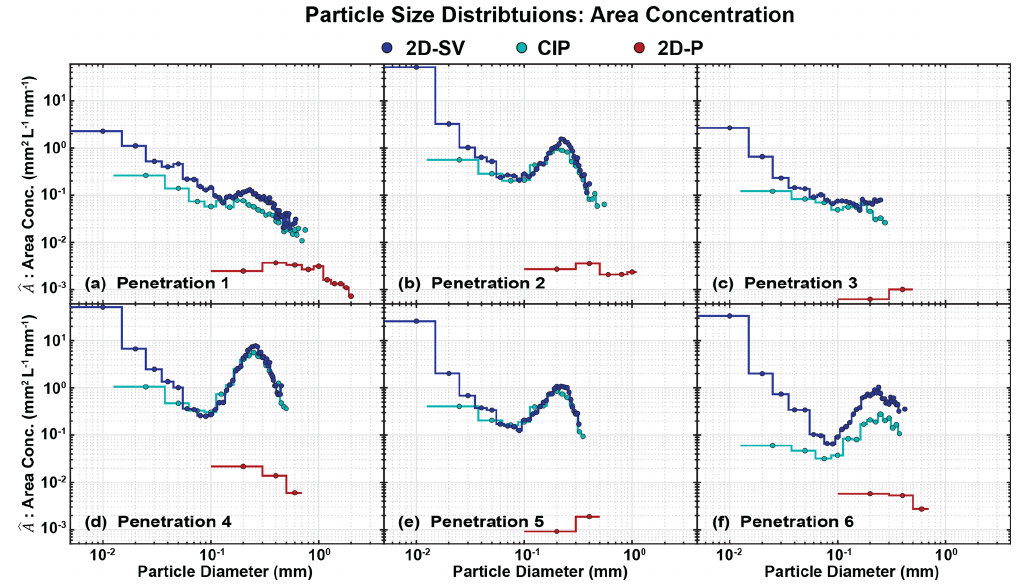
Figure 6. Same as Fig. 5 except for particle area concentration ( ˆ A